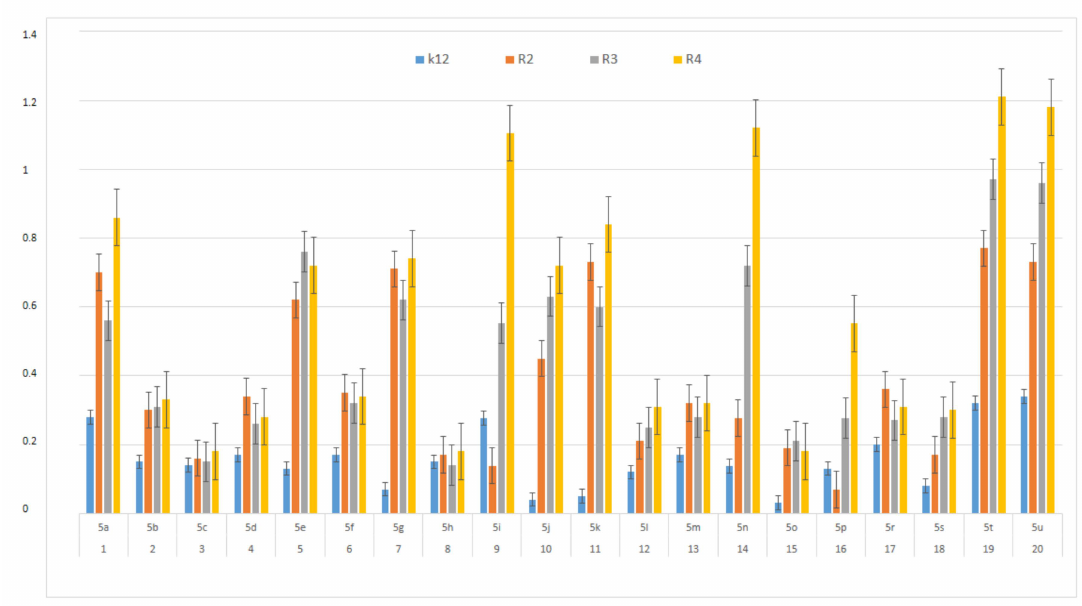
Figure 4. MIC of the α -amidoamids for the analysed strains of Escherichia coli K12 and R2, R2, and R4. The x-axis compounds 5a – 5u were used sequentially. The y-axis shows the MIC value in mg mL − 1 .